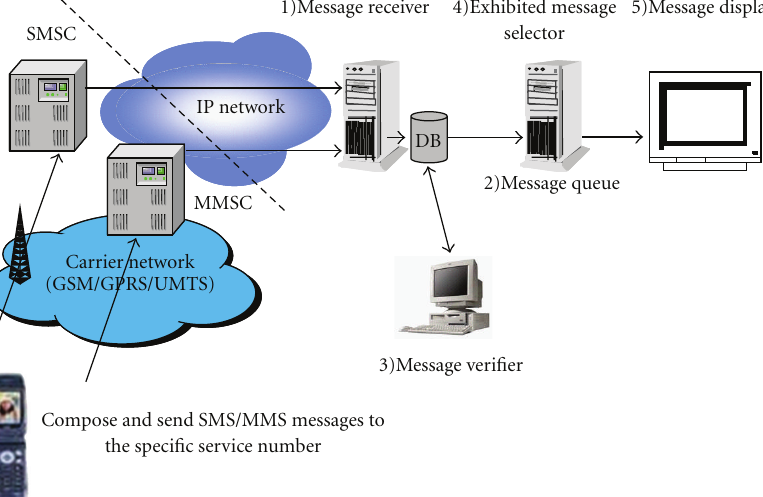
Figure 1: VSMMS system architecture.